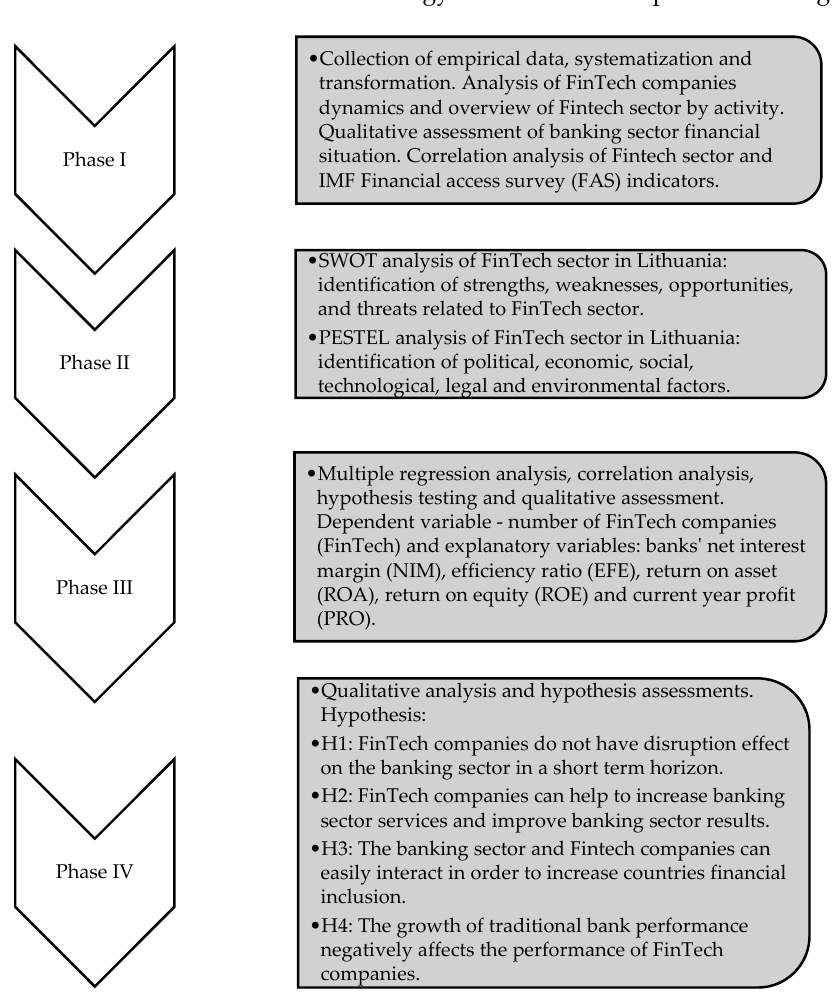
Figure 1. Framework of methodology. Phase 1. Empirical data required for analysis were collected, systematized and trans-